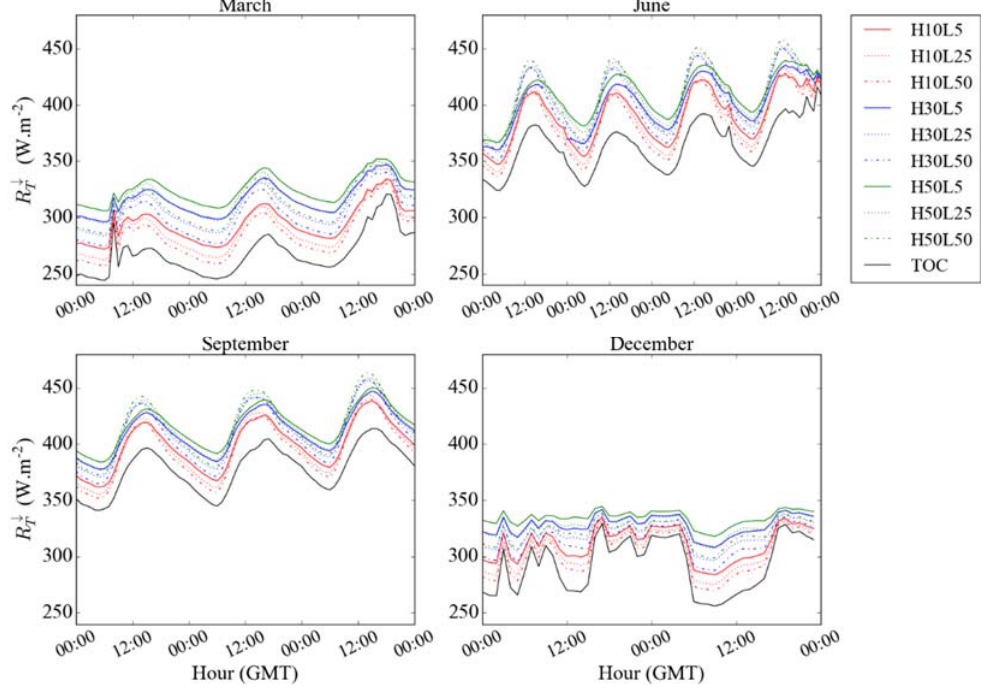
Figure 7. Top ‐ of ‐ canopy (TOC) downwelling TIR radiation and total downwelling TIR radiation for Figure 7. Top-of-canopy (TOC) downwelling TIR radiation and total downwelling TIR radiation nine canyon configurations (orientation 0°) for the four time periods (H = building height (m), L = for nine canyon configurations (orientation 0 ◦ ) for the four time periods (H = building height (m), street length (m)). L = street length (m)).